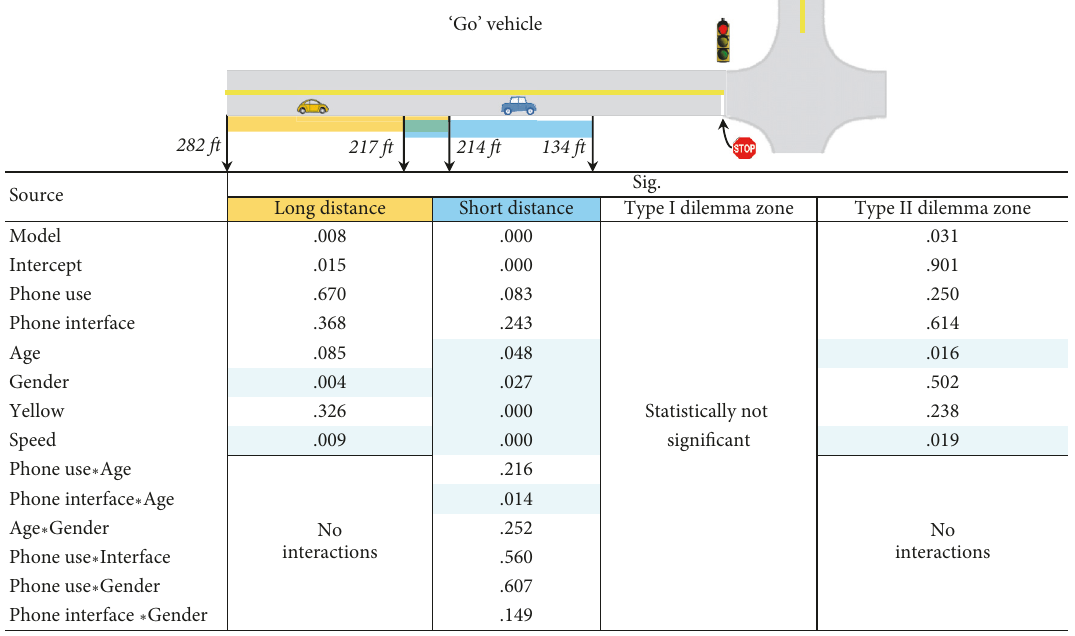
Figure 6: Different distances to stop line